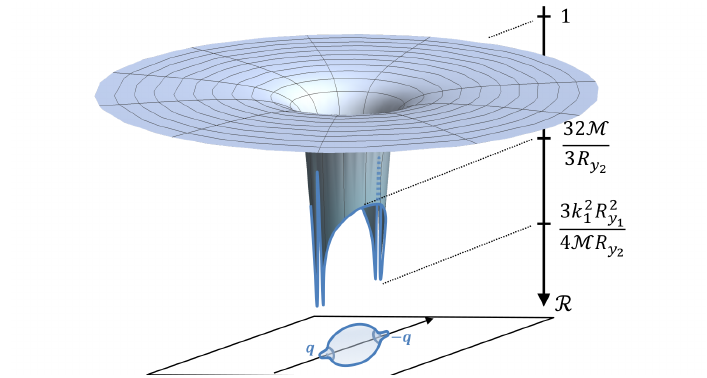
and k . , R y 1 R y 1 (cid:29) M 1 2